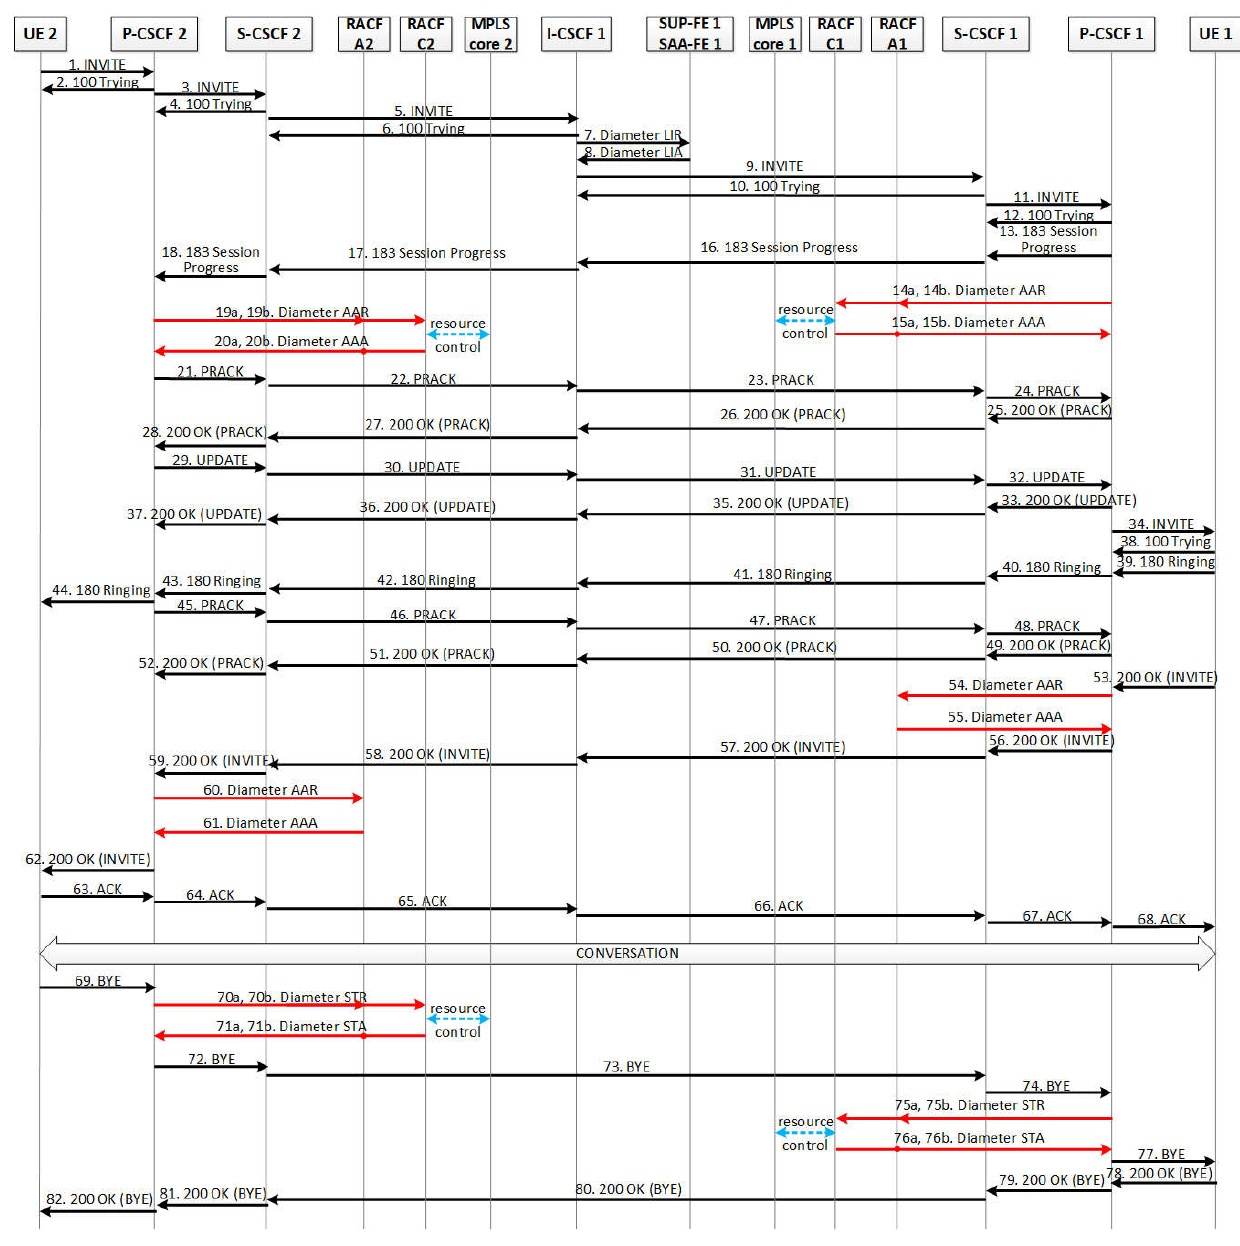
Figure 2. Message flow for the f2 call scenario (black arrows—communications using SIP protocol; red arrows—Diameter protocol; blue arrows—dedicated MPLS resource control protocol).